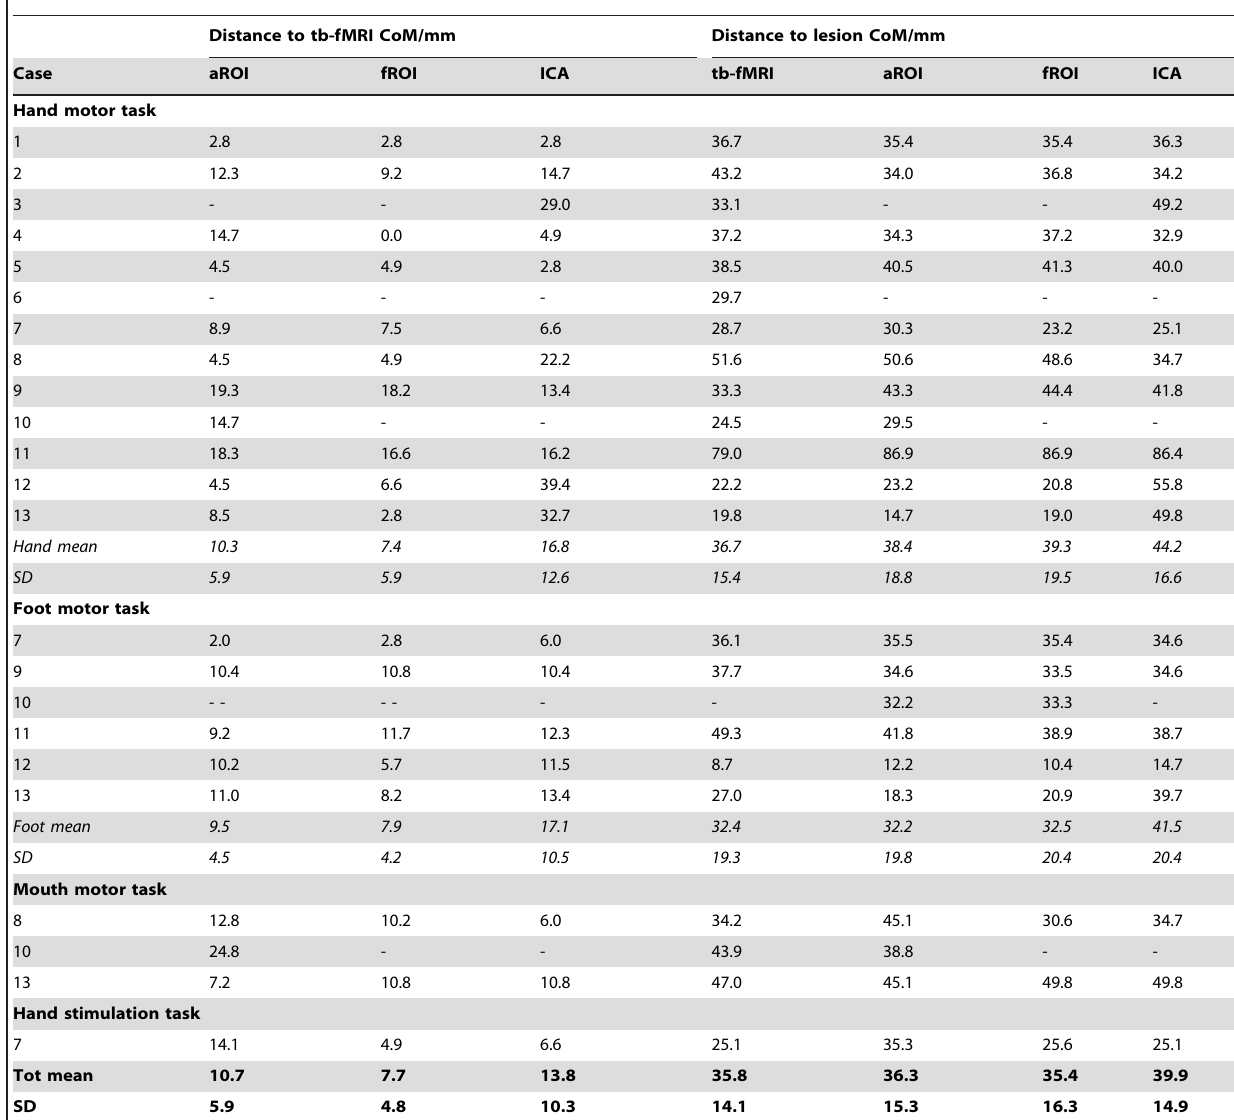
Table 7. Centre-of-mass (CoM) distance measurements with AMPLE thresholds.